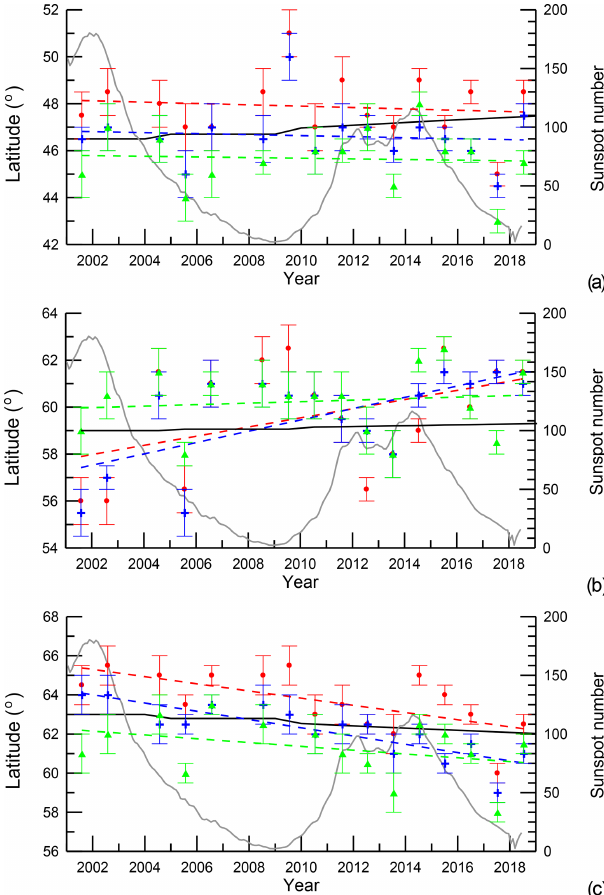
Figure 4. The geographic latitude of the maximum of the ORB measured at a height of ∼ 850km during geomagnetic quiet days around 80 ◦ W (a) , 0 ◦ E (b) and 100 ◦ E (c) for electrons with energies of >30keV (red circles), >100keV (blue crosses) and >300keV (green triangles). The dashed curves of corresponding colors show the best linear fit of the latitudinal change of the max- imum location by year (see Table 3). Solid black curves show the latitudinal change predicted by the IGRF model of corresponding epochs (see details in the text). The gray curve shows the sunspot number (right y axis).